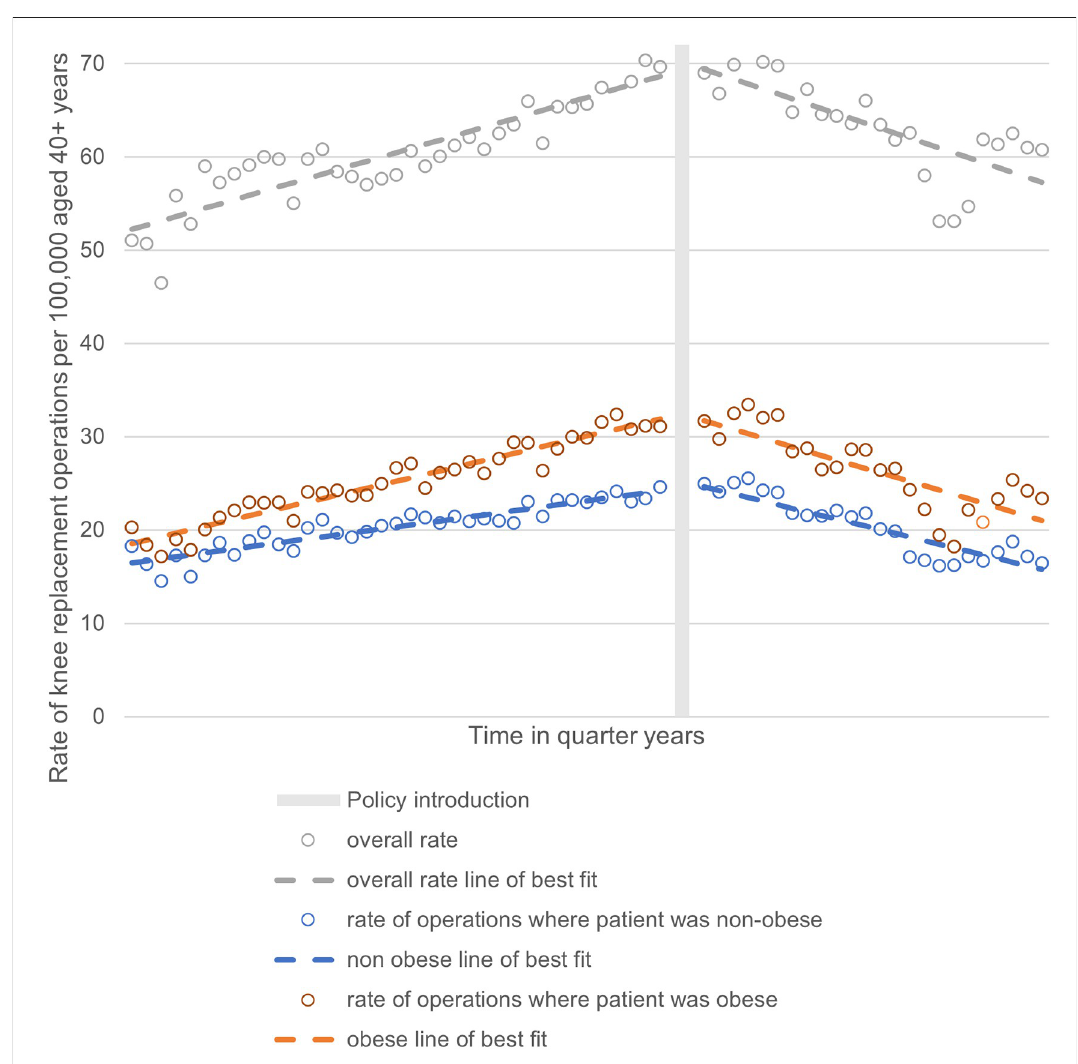
Fig 4. Stratification of rate of knee replacement operations by obesity in intervention